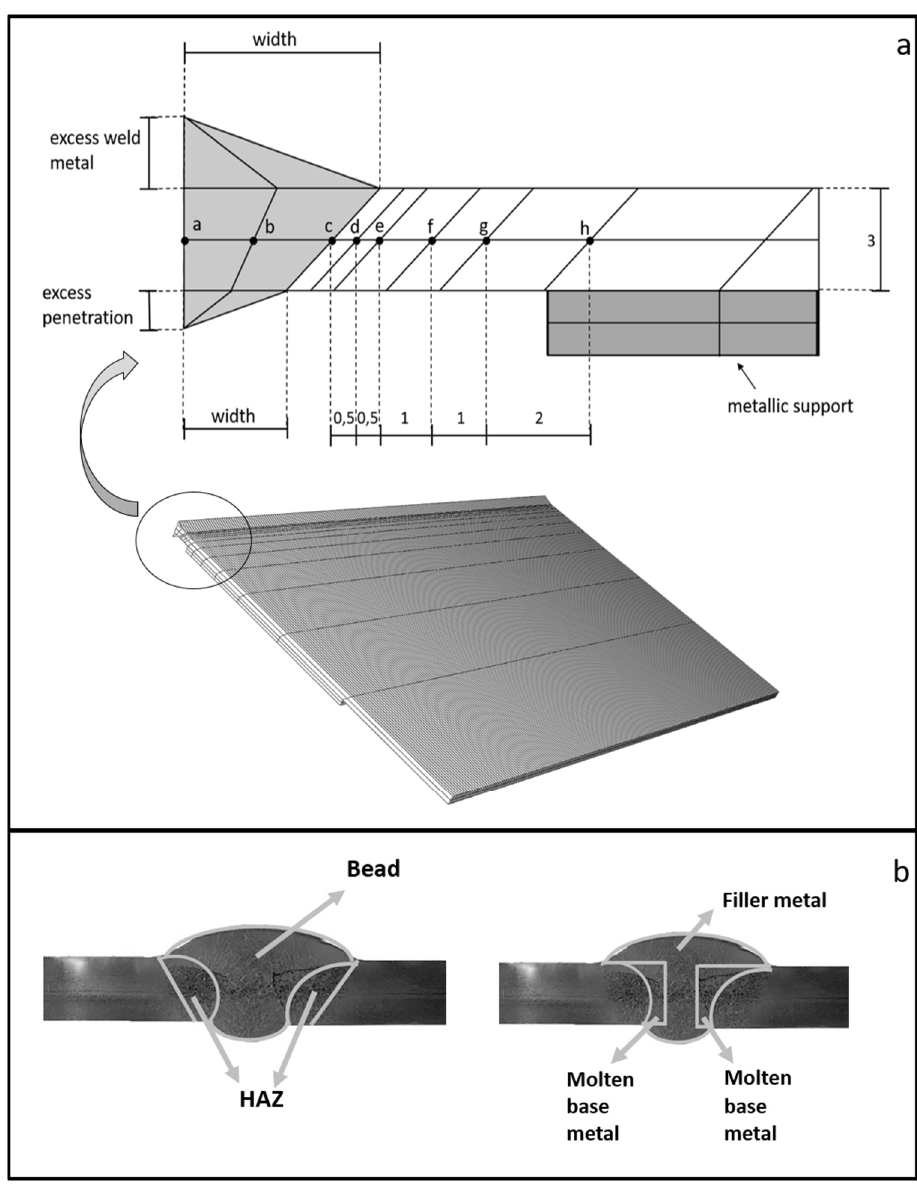
Figure 2. ( a ) Mesh used in FEM, ( b ) diagram of the zones studied for the dilution and diffusion of the alloys.